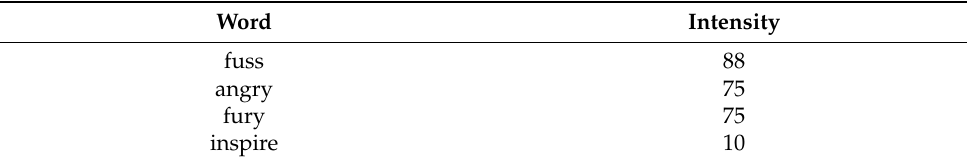
Table 4. Extract from the Intensity Lexicon for the effective anger class.